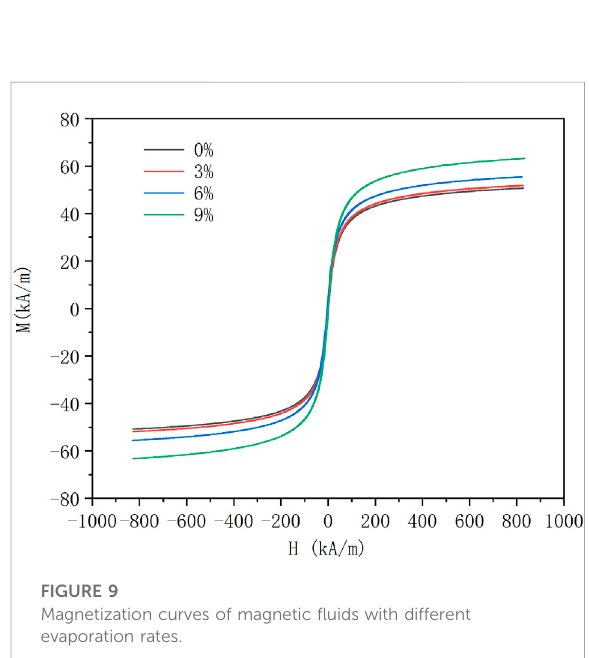
FIGURE 9 Magnetization curves of magnetic fl uids with different evaporation rates.